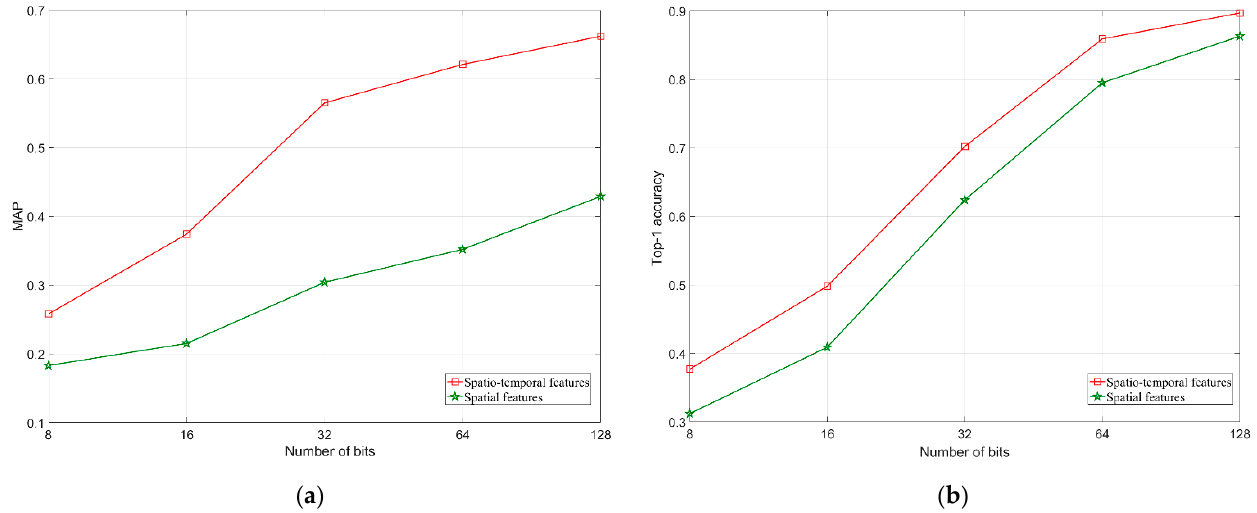
Figure 4. The accuracy comparison between spatio-temporal features and spatial features: ( a ) MAP comparison; ( b ) Top-1 accuracy comparison.